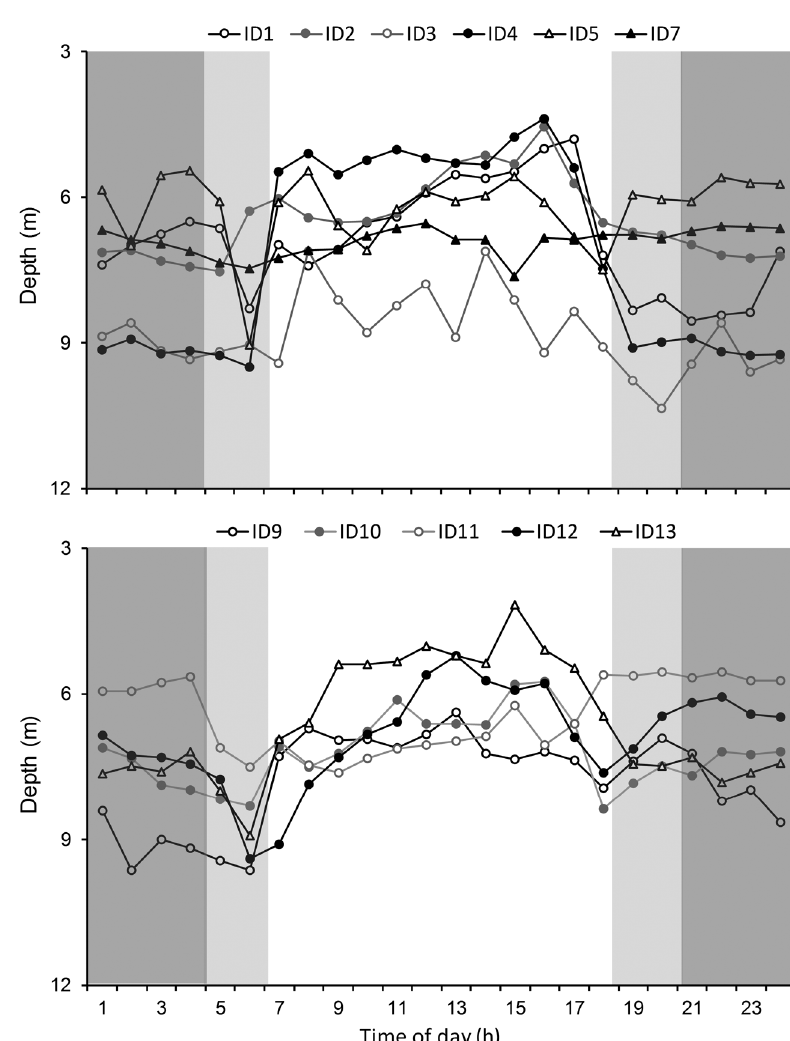
Fig. 6. Diurnal variation in vertical movements of the Sparus aurata tagged with depth sensors (upper panel: IDs 1−5 and 7; lower panel: IDs 9−13) around the farm during the 24 h of the day. Dark grey plot areas represent nighttime, and light grey areas represent sunrise and sunset periods. Fish cages with 6 m